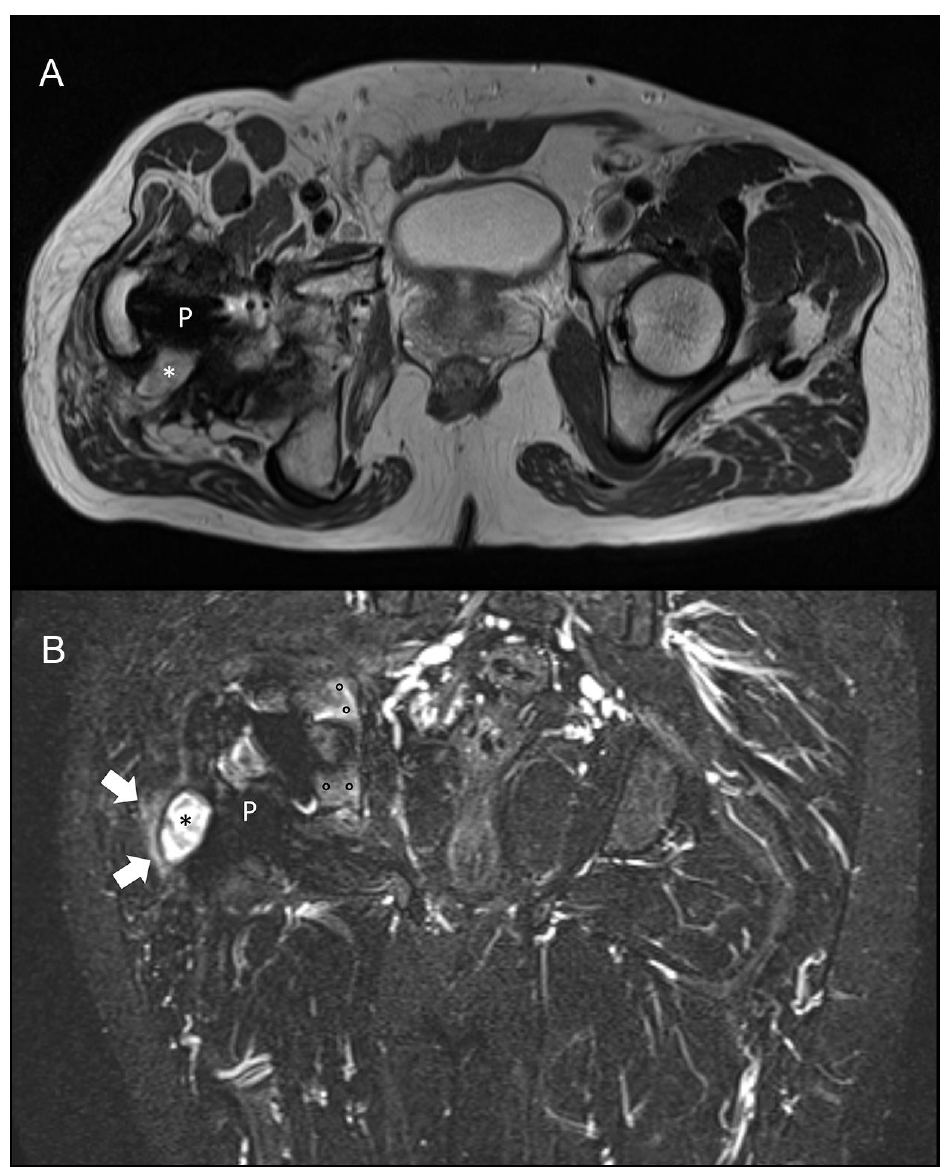
Figure 2. Magnetic resonance imaging (MRI) of a 58-year-old patient with culture-proven infected right hip prosthesis. ( A ) T2-weighted axial and ( B ) short-tau inversion recovery coronal scan show hyperintense synovitis (asterisks), extra-capsular edema (arrows), and bone edema (circles). Metallic artefact is limited to the implant only (P) and does not obscure the findings of infection.